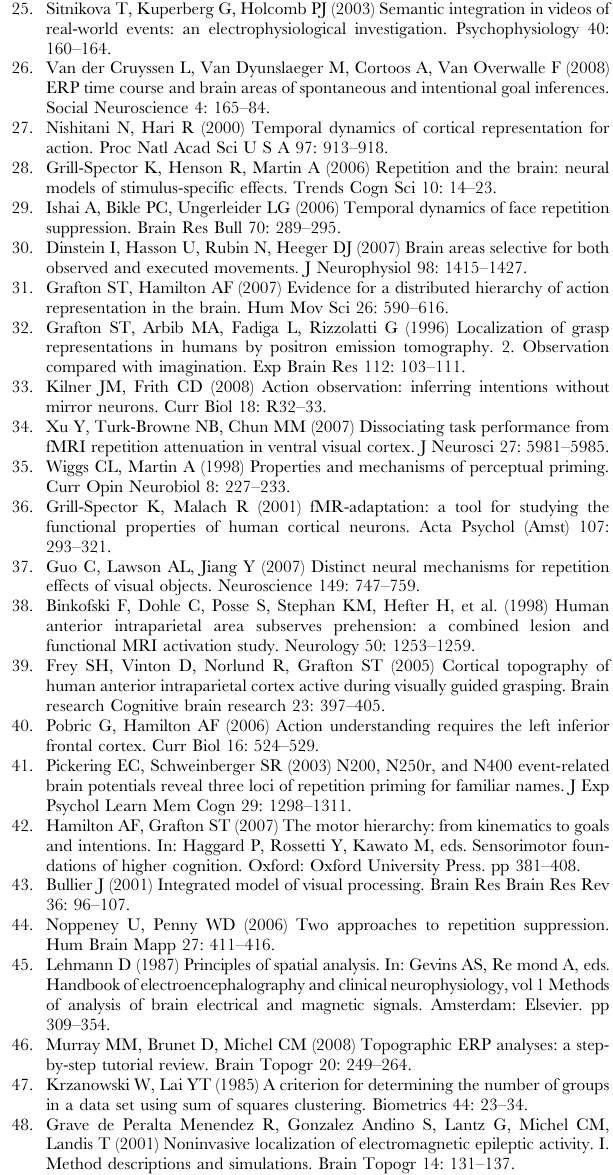
Table S2 Local maxima, with a Z values greater than 3 in each cluster, are provided in the table. Cluster size is in voxels. When the cluster encompasses more than one anatomical location, the localization given corresponds to the local maxima with the highest value. P , 0.001 uncorrected.